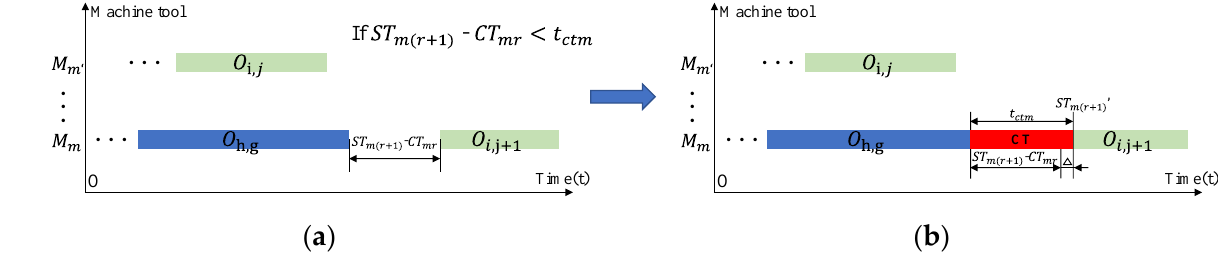
(1) (2) ( a ) ( b ) Figure 12. Scenario 6: ( 1 ) Sufficient machine-off time; ( 2 ) Insufficient machine-off time. ( a ) Initial Gantt chart; ( b ) Adjusted Gantt chart. 4.2.3. Crossover A crossover is used to maintain population diversity and explore a new solution space. In the parent population, two types of crossover were performed according to chro- mosome types [32], with the crossover of the process chromosome occurring in odd posi- tions, while that of the machine tool chromosome occurring in even positions, as shown in Figure 13.